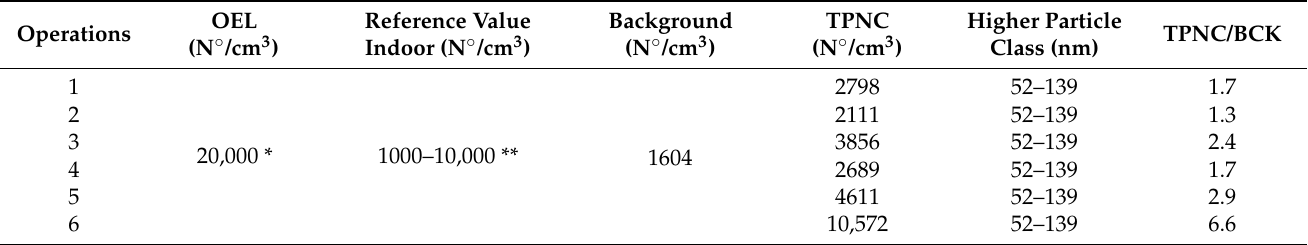
Table 6. Nanoparticle emissions during the monitored operations in AM and the relative ratio with the background value.